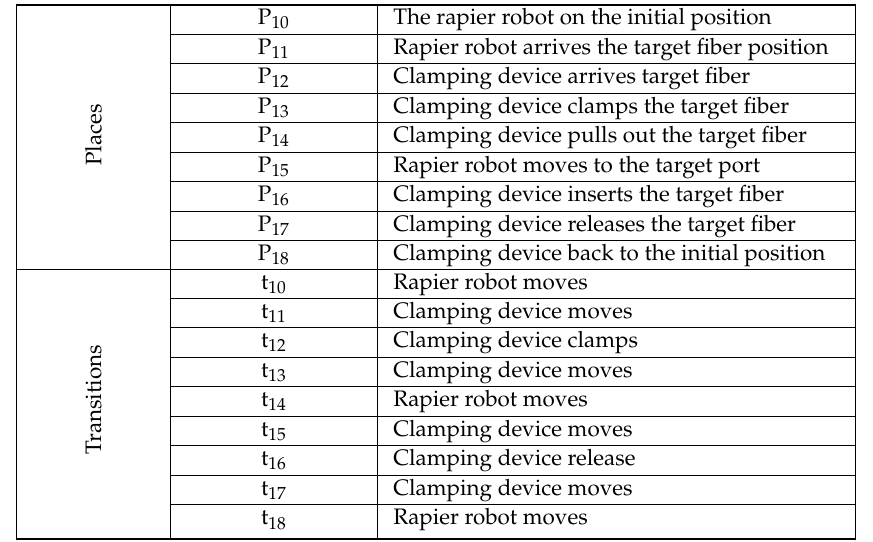
Table 2. Table of places and transitions (Tr) in the picking process.